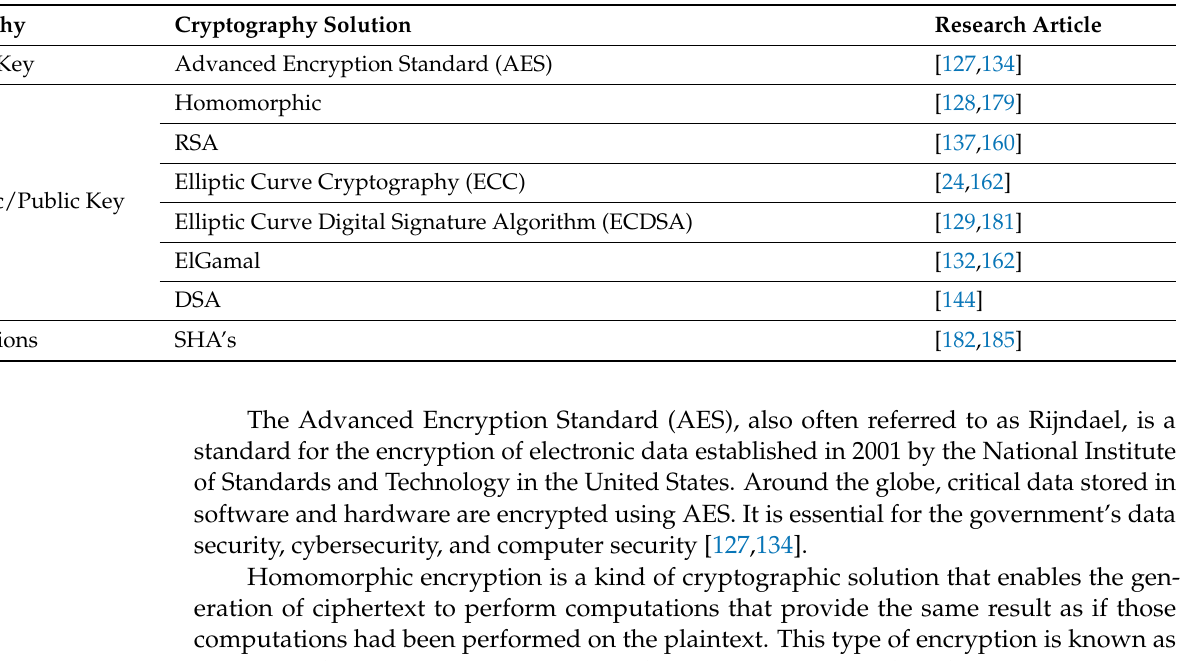
Table 11. Explicitly revealed cryptographic solutions in researched